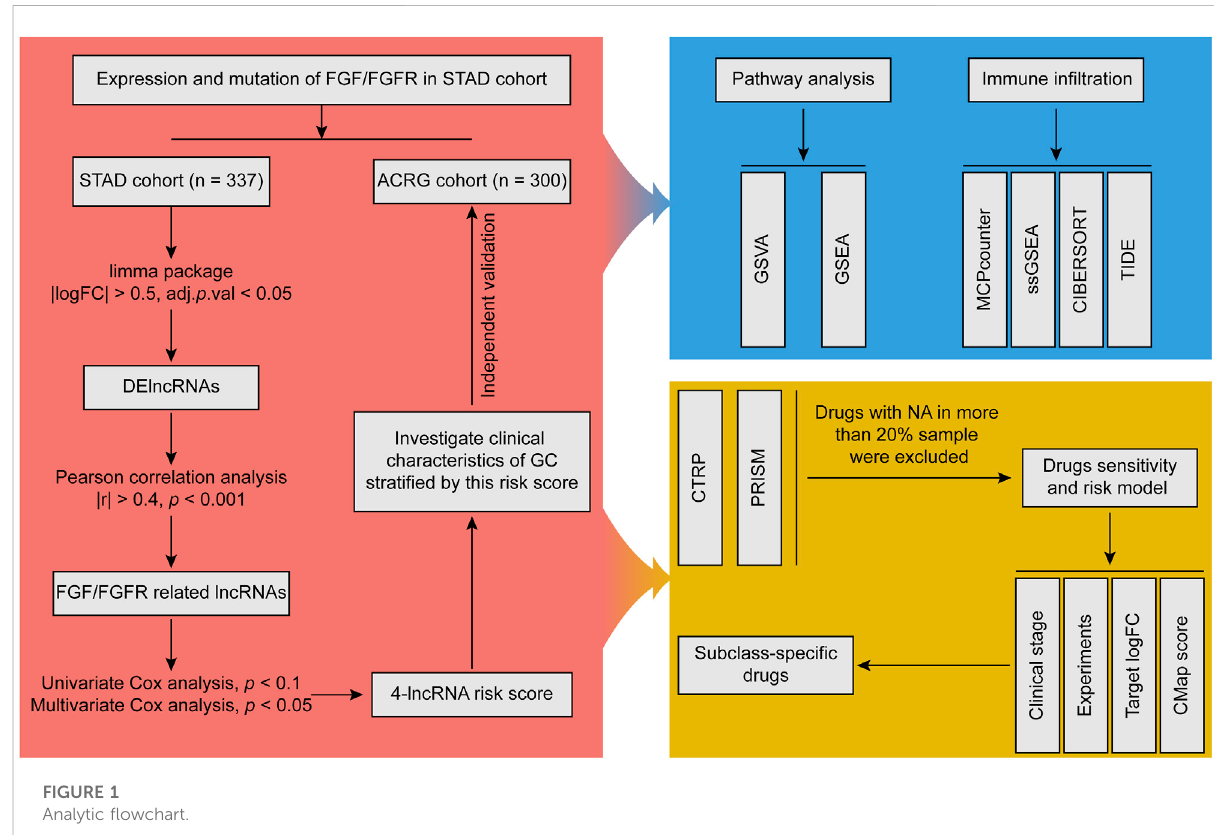
FIGURE 1 Analytic fl